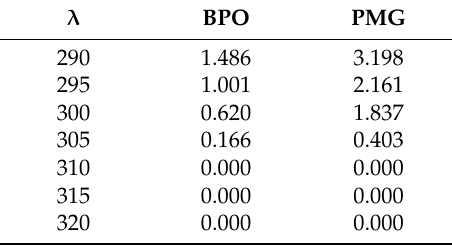
Table 4. Absorbance values at different wavelengths of shea oil (BPO) and pomegranate oil (PMG). λ BPO PMG 290